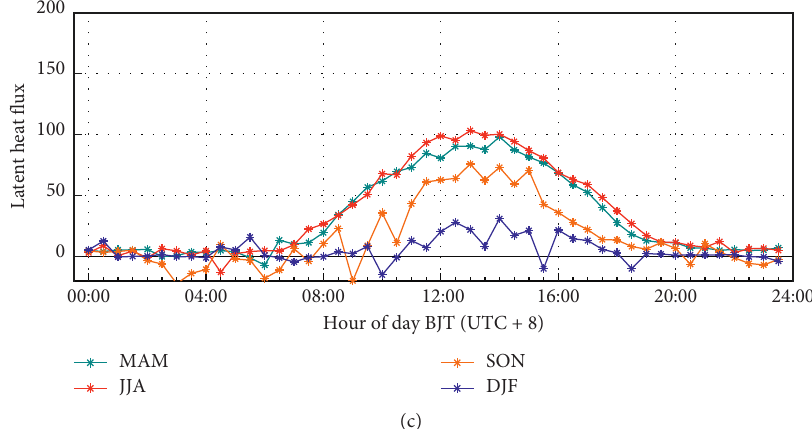
Figure 6: Diurnal variation of sensible and latent heat fluxes. Diurnal variation of sensible heat and latent heat fluxes in (a) and sensible heat flux and latent heat flux in different seasons in (b) and (c), respectively.